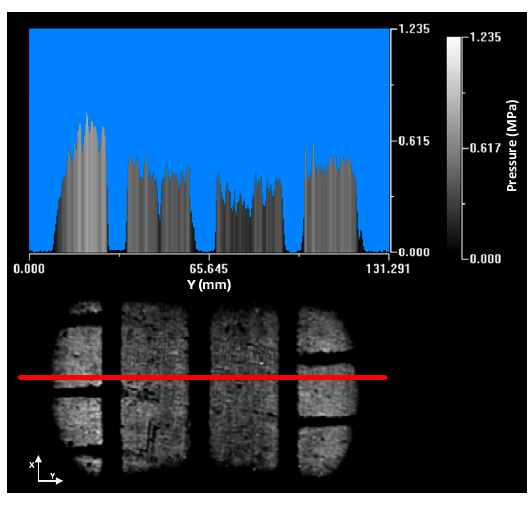
Figure 19. Cross profile.